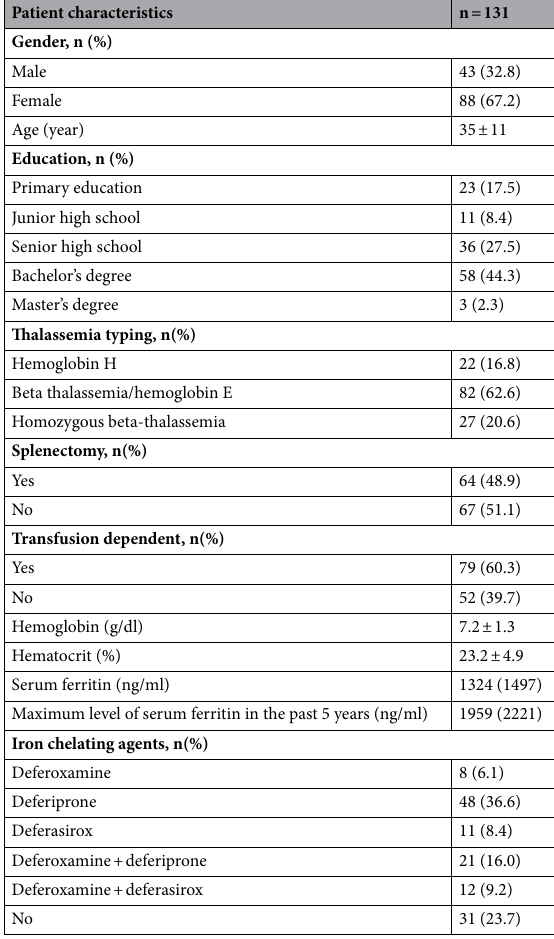
Fig. 2E. Additionally, full-length blots of FGF21 signaling proteins in brain were presented in Supplementary Fig. 1. Collectively, the upregulation of FGF21 level and the reduction in brain FGF21 signaling might imply that brain FGF21 resistance had developed in iron-overloaded thalassemic mice. Not only was there alteration in FGF21 in the brain, but the results also showed that the expression of post- synaptic protein (PSD95) was decreased in HFe-fed mice, compared to that in ND-fed mice (Fig. 3A), although the level of pre-synaptic protein (synaptophysin) did not change (Fig. 3B). Results pertaining to Alzheimer’s like pathology showed that both Amyloid-β/APP (Fig. 3C) and the phosphorylated-Tau Thr181 /Tau ratio in HFe-fed mice were up-regulated (Fig. 3D). All cropped representative bands for brain synaptic proteins and Alzheimer’s- like pathology were demonstrated in Fig. 3E. Furthermore, full-length blots of brain synaptic proteins and Alzheimer’s-like pathology were presented in Supplementary Fig. 2. These findings suggest that amyloid accu- mulation and tau-hyperphosphorylation were occurred in the brain of those mice. These results from both thalassemia patients and thalassemia mice suggest that cognitive impairment in thalassemia patients possibly occurs in association with brain FGF21 resistance which was shown in thalas- semia mice. Discussion Major findings from this study are as follows: (1) MCI condition occurred in thalassemia patients, (2) hema- tologic parameters including serum ferritin level and maximum level of serum ferritin in the past 5 years were significantly increased in thalassemia patients with MCI, (3) clinically, plasma FGF21 level showed an independ- ent association with MCI, (4) mechanistically, brain FGF21 resistance may be related to the alteration of brain